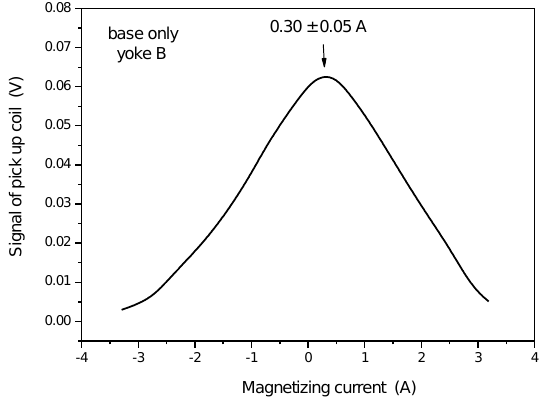
Figure 12. Signal of the pick-up coil as a function of the magnetizing current, measured on the base material by applying Yoke B.